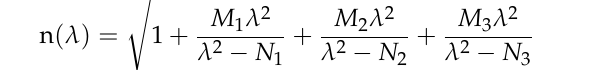
Table 1. Parameter values of the Drude–Lorentz model.